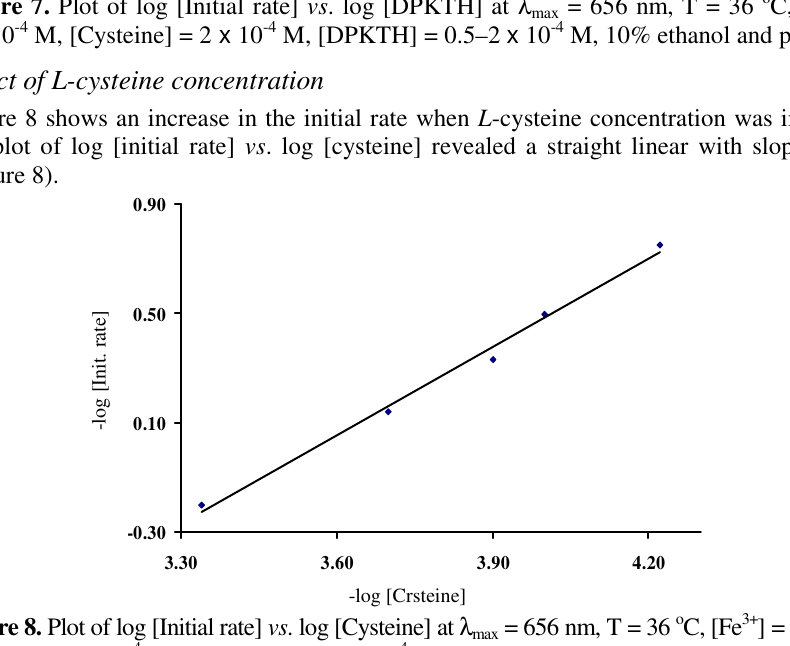
= 656 nm, T = 36 o C, [Fe 3+ ] = max